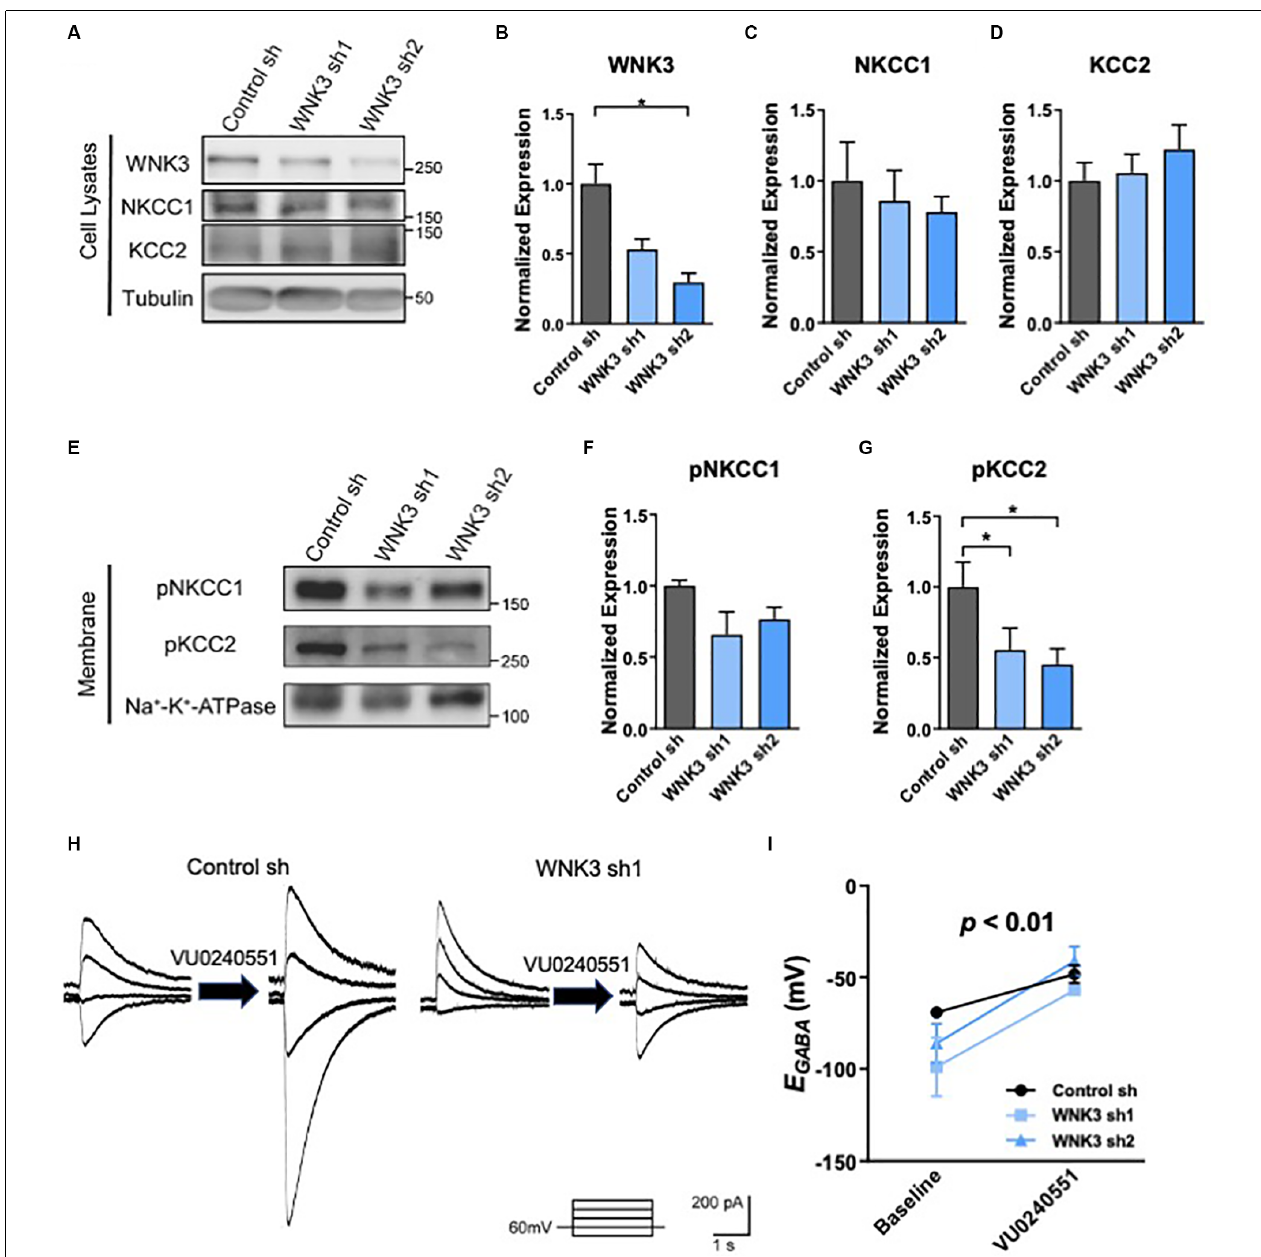
FIGURE 3 | The role of KCC2 chloride transport in E GABA hyperpolarization in shWNK3 developed neurons. (A) Representative Western blots showing the expression of WNK3, NKCC1, and KCC2 in WNK3 sh1 and sh2 neurons at DIV 14. (B–D) Quantification of WNK3, NKCC1, and KCC2 protein expression from (A) , protein expression levels were normalized to their respective loading controls and expressed relative to control sh levels, n = 3 cultures, * p < 0.05, One-way ANOVA with Bonferroni post-hoc . (E) Representative Western blots showing the membrane expression of phosphorylated NKCC1 and KCC2 in WNK3 sh1 and sh2 neurons at DIV 14. (F,G) Quantification of phosphorylated NKCC1 and KCC2 protein expression in membrane from (E) , protein expression levels were normalized to Na*-K + -ATPase, and expressed relative to control sh levels, n = 3 cultures, * p < 0.05, One-way ANOVA with Bonferroni post-hoc . (H) Representative image